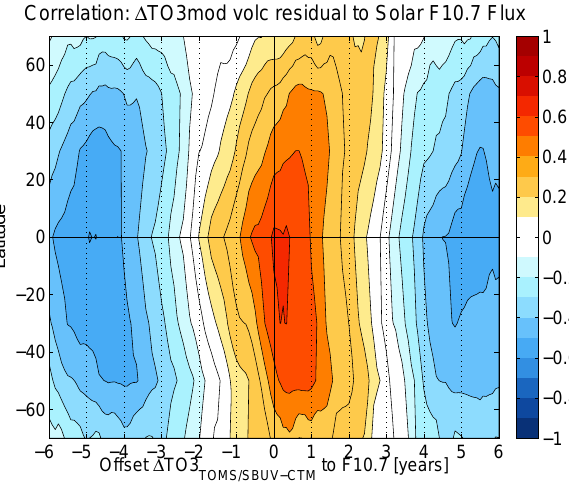
Fig. 4. TO3 offsets due to polar ozone depletion and its export (dif- ferences of runs tn − tc ), given inDU for all latitudes and months, averaged over the ERA-Interim driven period (1989-2009).